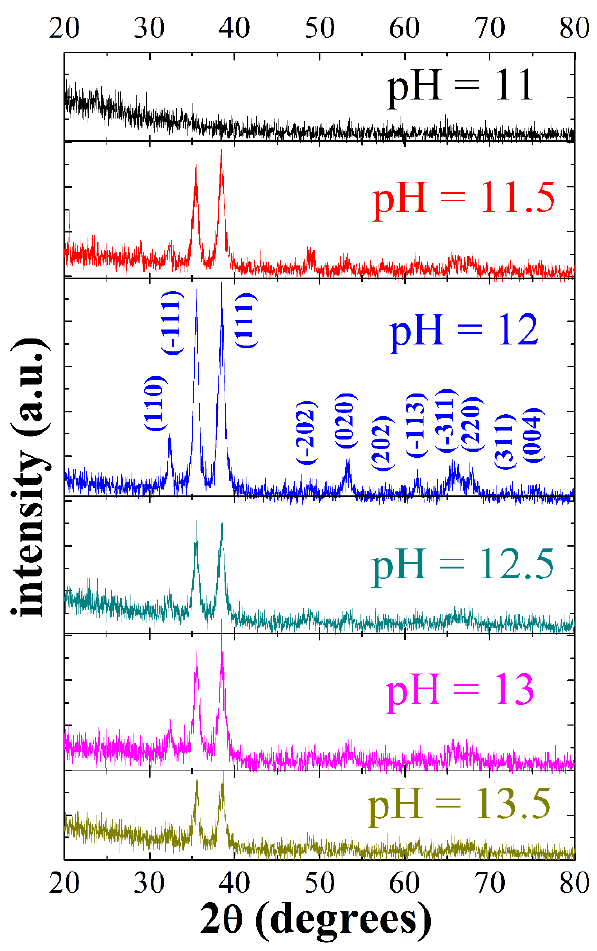
Figure 3. X-ray diffraction patterns of the as-prepared MWCBD-CuO films with different pH values. The influence of secondary chemical reactions due to the solution solubility, and